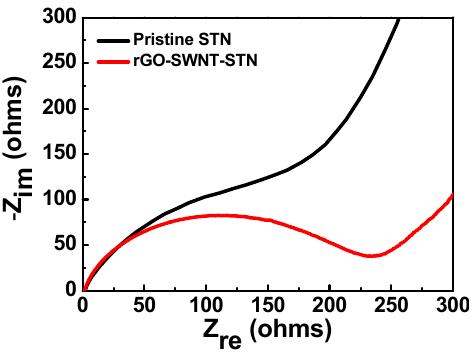
Figure 6. SEM images of rGO-SWNT-STN electrode for ( a ) full lithiation, and ( b ) delithiation at the first cycle.